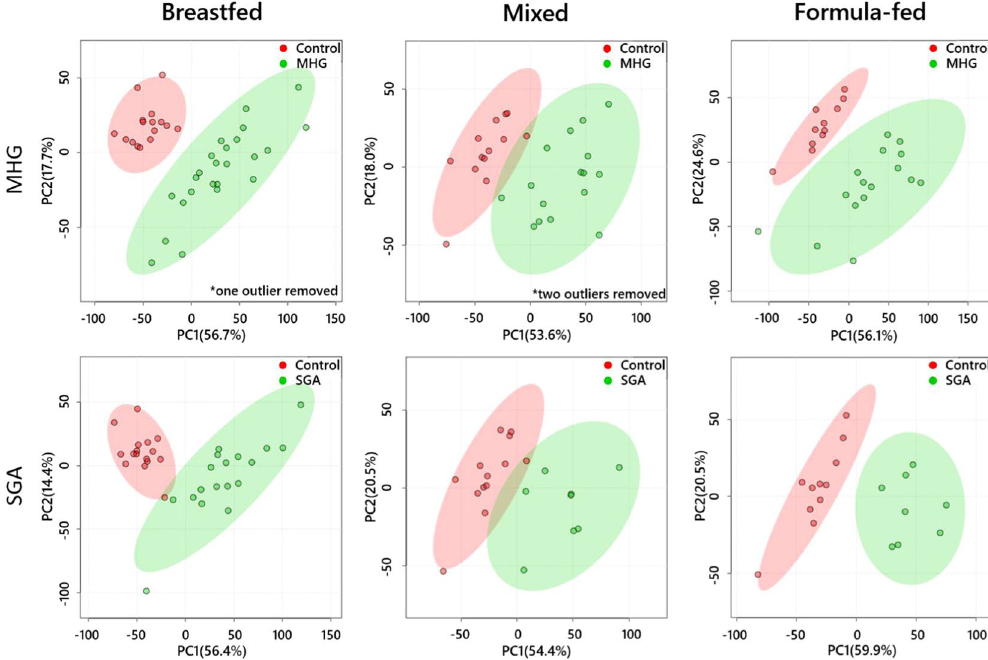
Figure 2. Principal Component Analyses of lipid profiles of infants born as SGA or from mothers with gestational diabetes (green) against controls